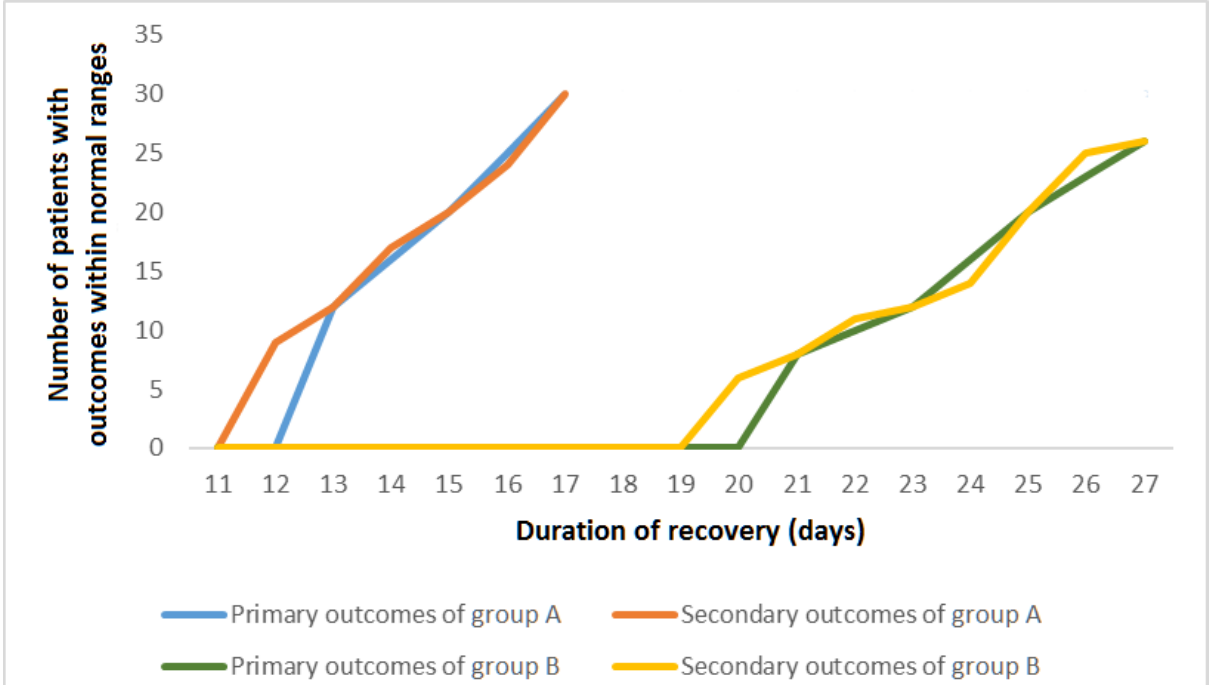
Figure 3. Patient outcome recovery rates.